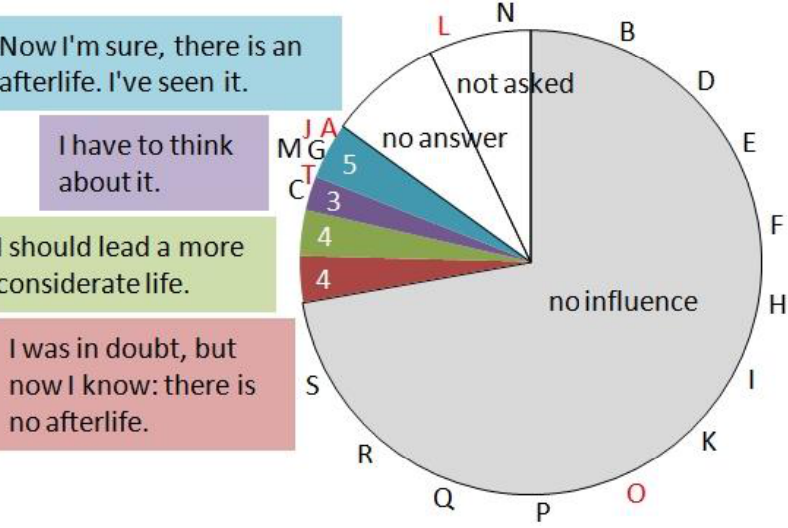
Figure 3. Influence on religious conviction. Patients were asked whether their CA had an influence on their religious conviction. Mostly, believers stayed believers, and non-believers remained in their position. However, 16 cases (the sectors in color) changed their mind. Cases with memories (capitals, in red with ≥ 7 Greyson points) cluster at one of the sectors .